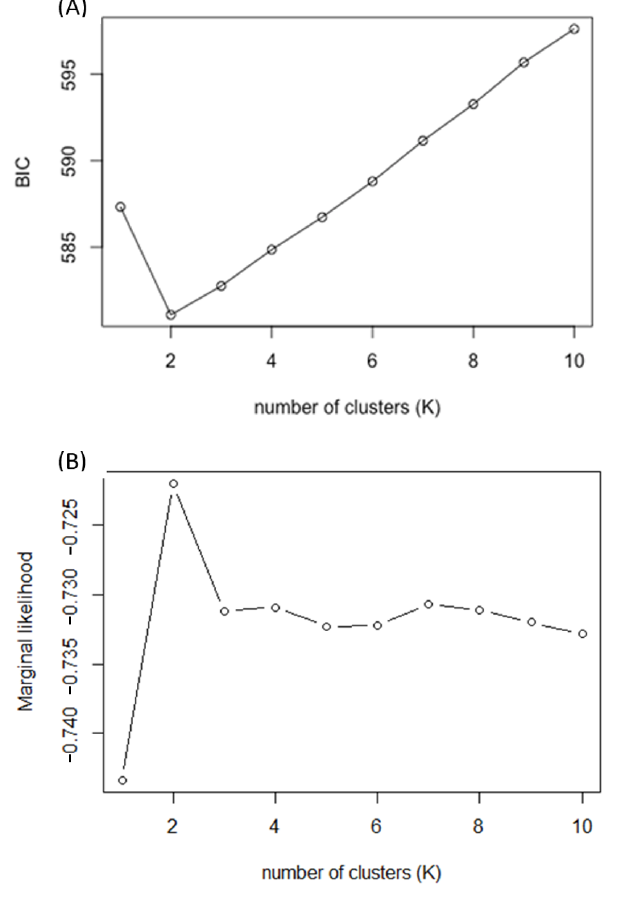
Figure A2. ( A ) Graph showing number of potential genetic clusters ( K ) associated with value of Bayesian Information Criterion (BIC) calculated using DAPC algorithm. ( B ) Graph showing number of potential genetic clusters ( K ) associated with model marginal likelihood calculated using fastSTRUCTURE algorithm.